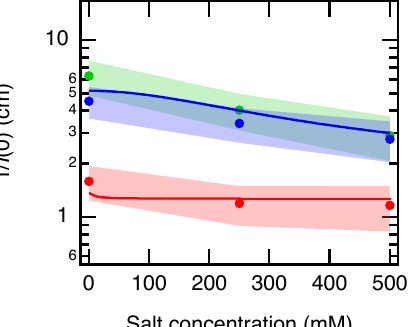
Figure 6. Averaged 1/ I (0) of PAA gels and solutions as a function of salt (NaCl) concentrations. N0, N50, and N100 denote gels with different neutralization degrees. I (0) were determined from the intensity values at q = 0.025 Å − 1 from Figure 4. The solid curves indicate the model curves of K os calculated as a sum of Equations (6) and (7). The red curve is calculated for α = 0.005 and the blue curve for α = 0.2. The model curve was vertically scaled by a factor of 8 to match 1/ I (0) values. See the main text for the details of the